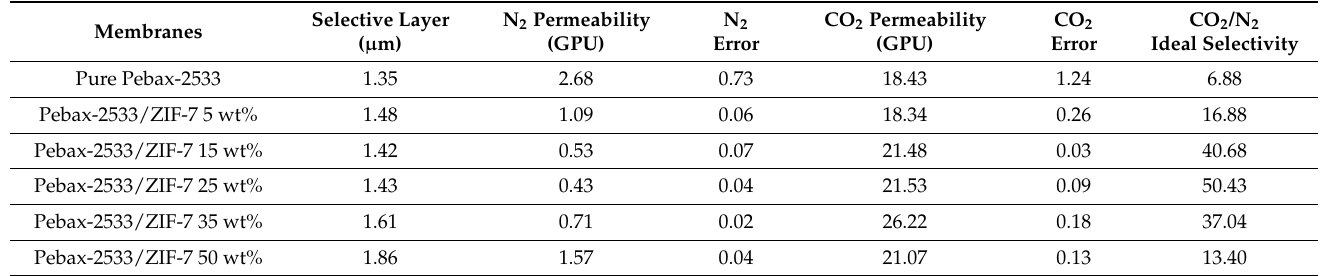
Figure 15. CO 2 /N 2 ideal selectivity of Pebax ‐ 2533/ZIF ‐ 7 composite membranes. Table 5. Gas permeance properties of Pebax ‐ 2533/ZIF ‐ 7 composite membranes.